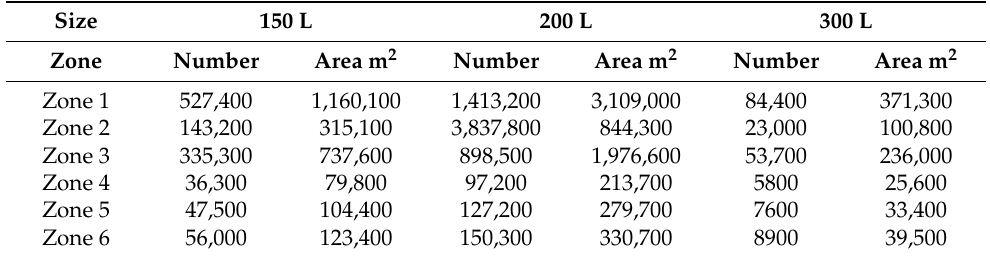
Table 8. The number of thermosyphon solar water heaters (TSWH) to be installed. Size 150 L 200 L 300 L